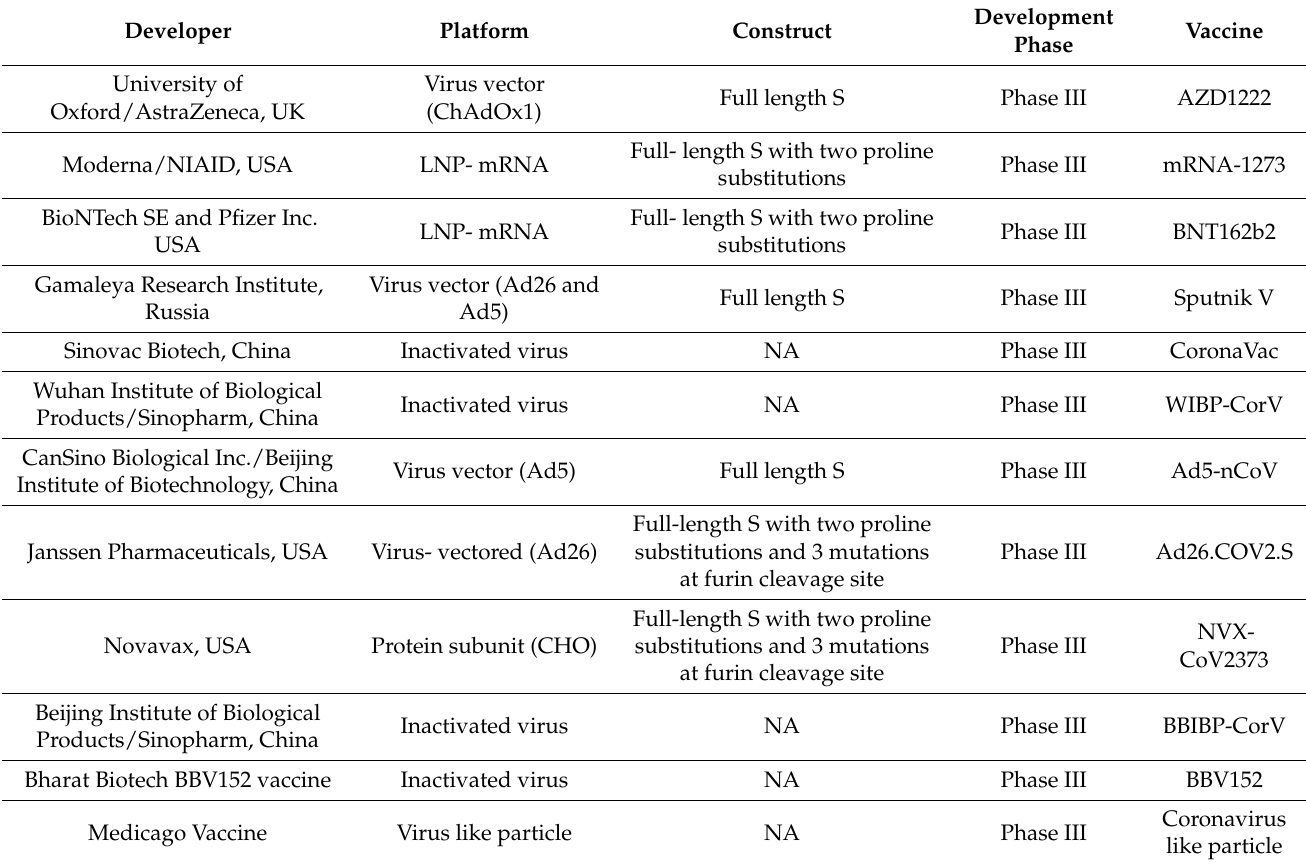
Table 1. Most promising vaccines, their developers, platforms and constructs, and the clinical phases in which these vaccines are currently being tested